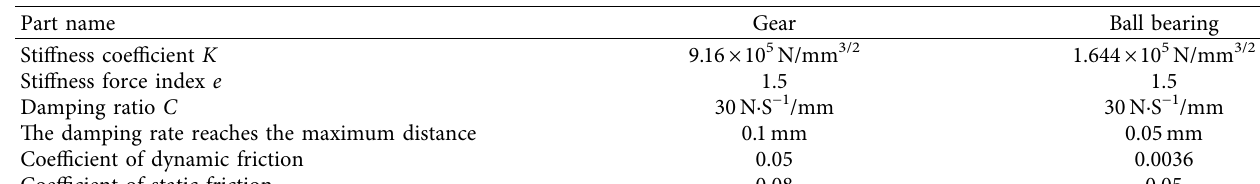
Figure 3: Internal details of active control structure. 1: actuator support, 2: piezoelectric actuator, 3: antiload rod, 4: support bearing, and 5: meshing line. Table 2: Gears at all levels.